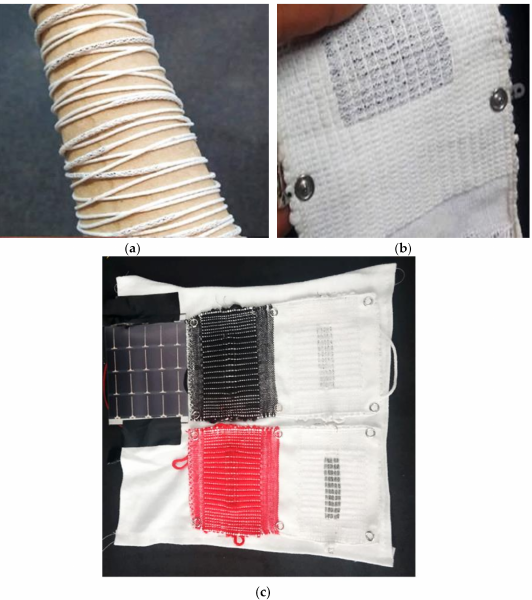
Figure 13. Ten individually soldered and encapsulated solar cells are used to create Solar-E yarns ( a ). Two hundred solar cells are integrated into a solar harvesting cloth ( b ). a commercially available flexible solar cell, and solar energy-harvesting textiles, each containing 50 solar cells ( c )